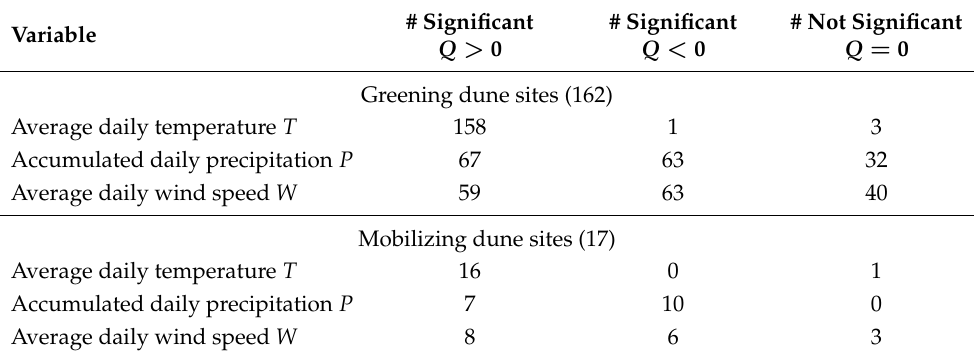
Table 3. Mann–Kendall test results ( α = 0.01) for the daily climate